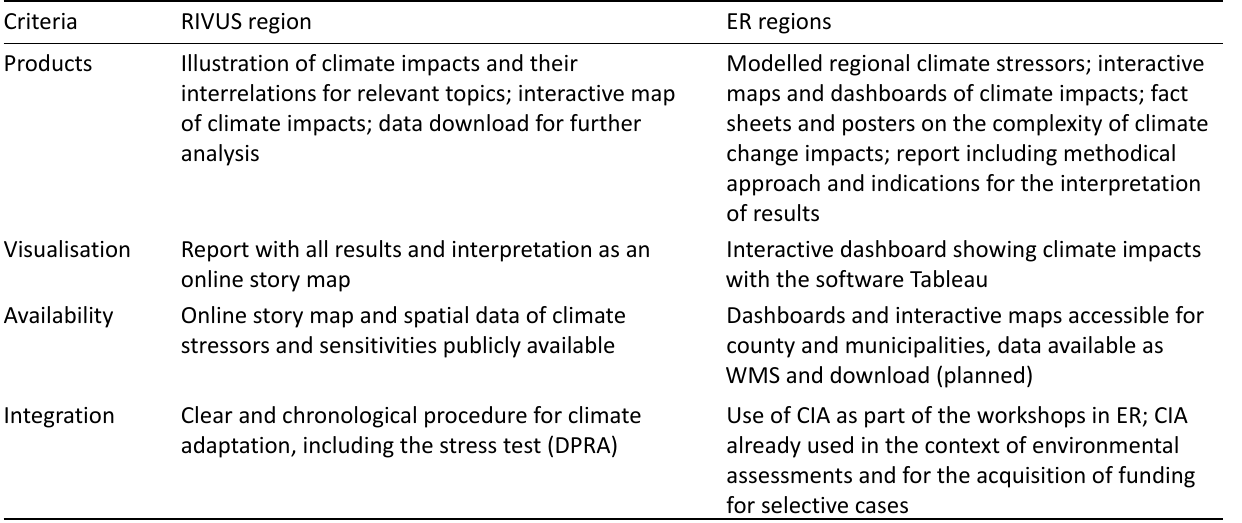
Table 4. Overview of the comparison criteria of the